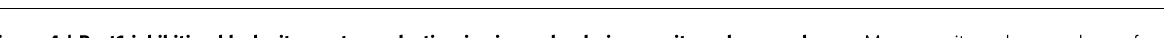
Figure 4 | Bcat1 inhibition blocks itaconate production in vivo and polarizes peritoneal macrophages. Mouse peritoneal macrophages from vehicle (saline), LPS-injected (1.5mgkg (cid:2) 1 ) or LPS þ ERG240 (500mgkg (cid:2) 1 )–injected mice were isolated and pooled 24h following i.p. injection ( n ¼ 6 mice per group). Irg1 protein ( a ), mRNA ( b ) levels, as well as itaconate measurements by GC/MS ( c ) are shown. The lower panel ( c ) shows itaconate levels in peritoneal macrophages isolated from mice injected either with LPS or LPS þ ERG240 or a sequential treatment where LPS was first injected for 3h, followed by ERG240 (LPS þ ERG240 (sequential)). Peritoneal macrophages were collected 24h following the LPS injection. n ¼ 3 mice/group. ( d ) Protein–protein interaction (PPI) network in 100 top (97 annotated) differentially expressed genes between LPS and LPS þ ERG240 treated mouse peritoneal macrophages illustrated by STRING (high confidence score ¼ 0.7). The IFN-inducible GTPase cluster is shown within a dashed circle. ( e ) Distribution of the fold changes and the FDR-adjusted P values ( (cid:2) log 10 (FDR)) for the comparison between LPS and LPS þ ERG240 treated macrophages. The IFN- inducible GTPase genes, M1-like, M2-like and extracellular matrix transcripts are shown in blue. ( f ) Fragments per kilobase of transcript per Million mapped reads (FPKM) values for Nos2 , Il6 are shown in vehicle, LPS and LPS þ ERG240-treated peritoneal macrophages. ( g ) FPKM values for Ifit1 , Ifit2 , Ifit3 , Gbp1 , Gbp2 , Gbp4 , Gbp7 , Mrc1 , Klf4 , Cd36 , Fn1 , Mmp9 , Gsn and Spp1 . FPKM ¼ 1 is shown as a dashed line to denote minimal expression levels. All transcripts analysed by RNA-seq ( f , g ) show significant FPKM upon ERG240 treatment when compared to LPS group (FDR o 10 (cid:2) 73 ). Error bars are s.e.m. Significance was tested using one-way ANOVA. * P o 0.05 by